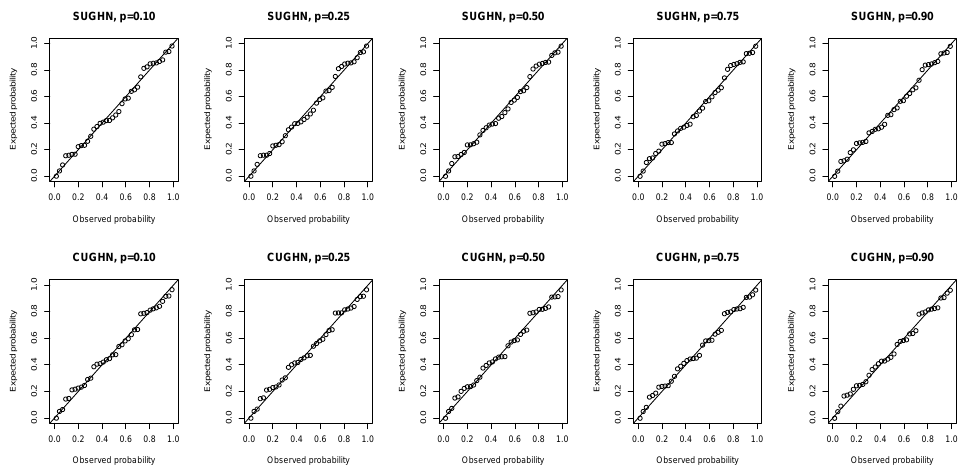
Figure 6. P–P plots of randomized quantile residuals of the SUGHN and CUGHN regression models.